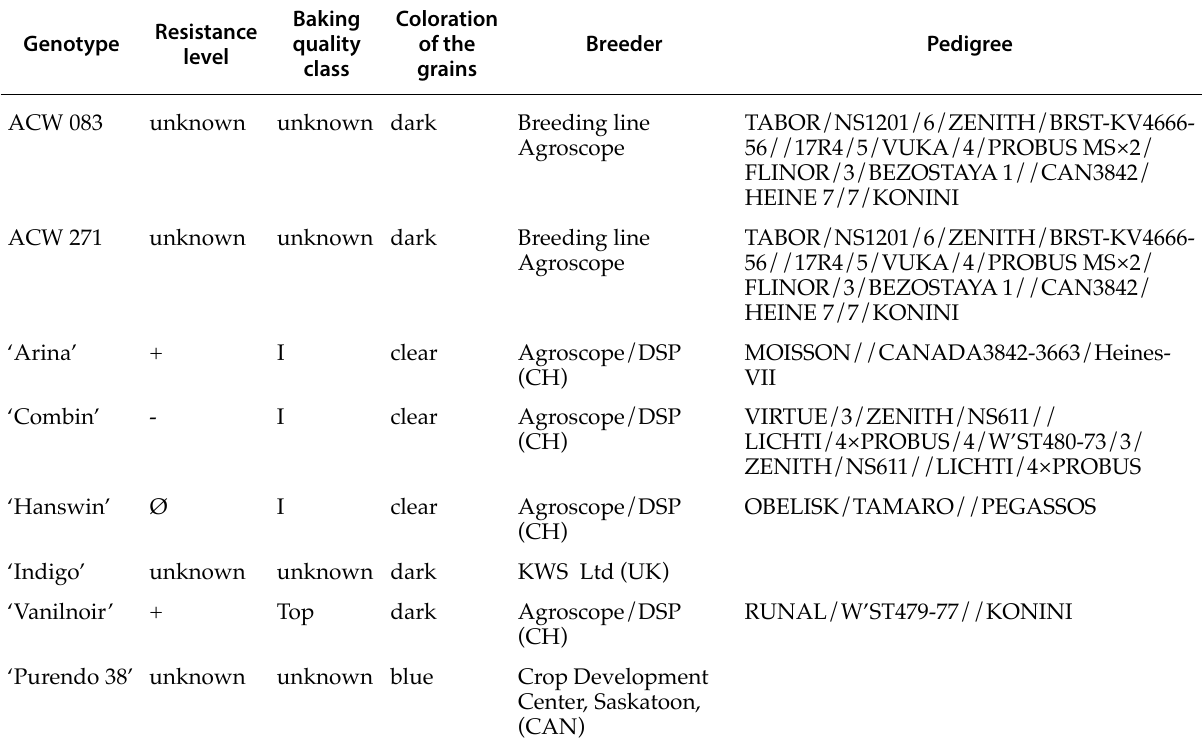
Table 1. Description of winter wheat genotypes investigated in this study. + = resistant, - = susceptible, and Ø = non- significant resistant